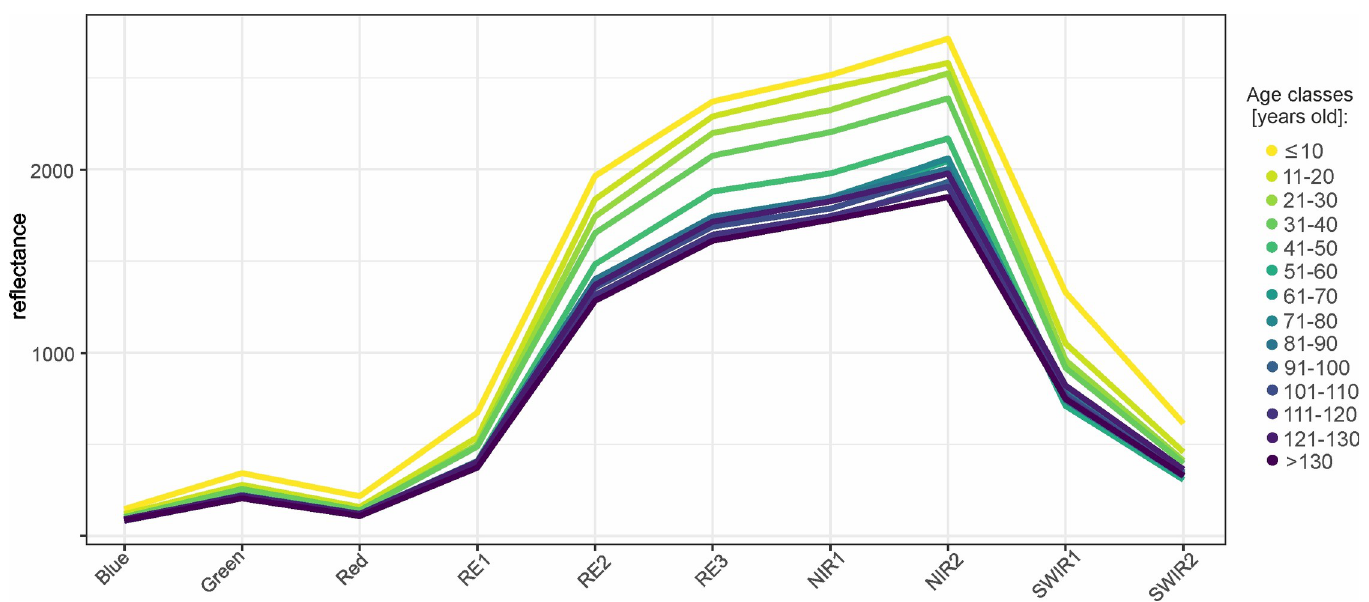
Fig 6. Mean reflectance for the 10-years age classes of Silver fir stands on September 22nd.